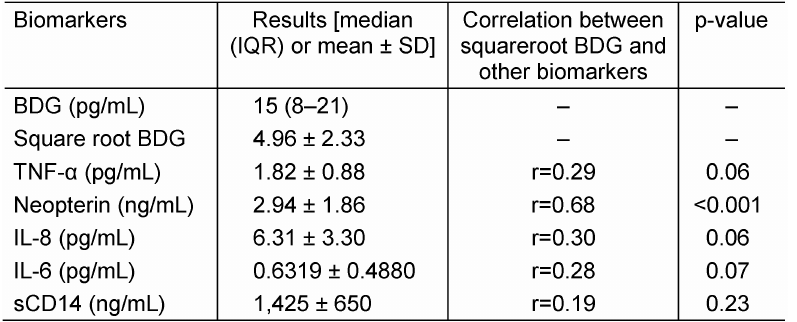
Table 1: Results for all investigated biomarkers [median and (IQR) or mean ± standard deviation (SD) are displayed]